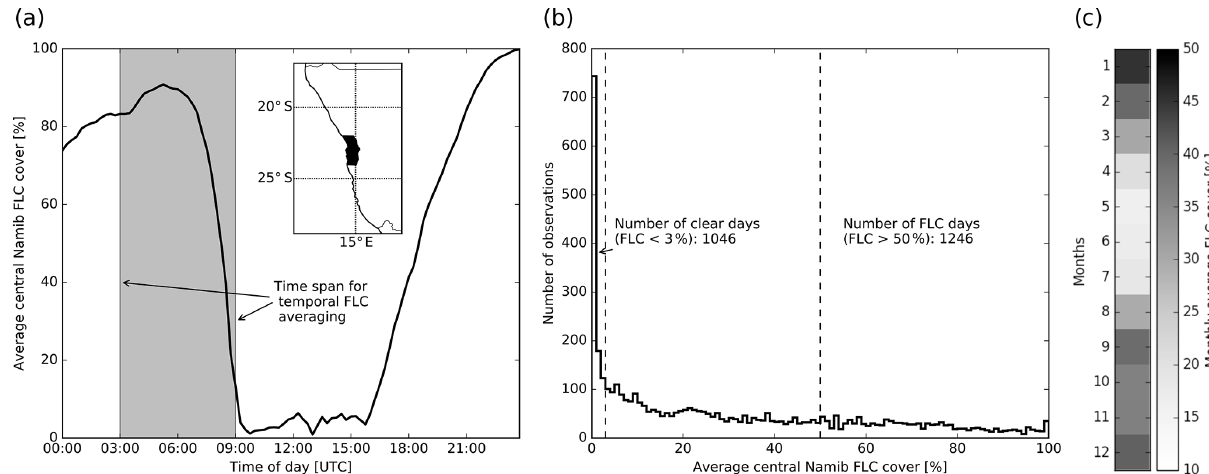
Figure 1. (a) Illustration of the spatiotemporal averaging for one exemplary day (9 September 2015) to create the FLC cover data set. The curve in (a) shows the regionally averaged (marked central Namib region) FLC occurrence, which is then averaged between 03:00 and 09:00UTC (grey area). The resulting average daily morning FLC cover is given in percent. (b) Distribution of the resulting FLC cover in the central Namib for the complete observation period (2004–2017). Observations are separated in two classes: clear days ( < 3% mean FLC cover) and FLC days (mean FLC cover > 50%). Days with mean FLC cover between 3% and 50% are not considered in analyses based on this classification (2418 cases for 404d of FLC cover could not be computed due to missing data or complete coverage with higher-level clouds). Panel (c) shows monthly averages of the spatiotemporally averaged FLC cover data